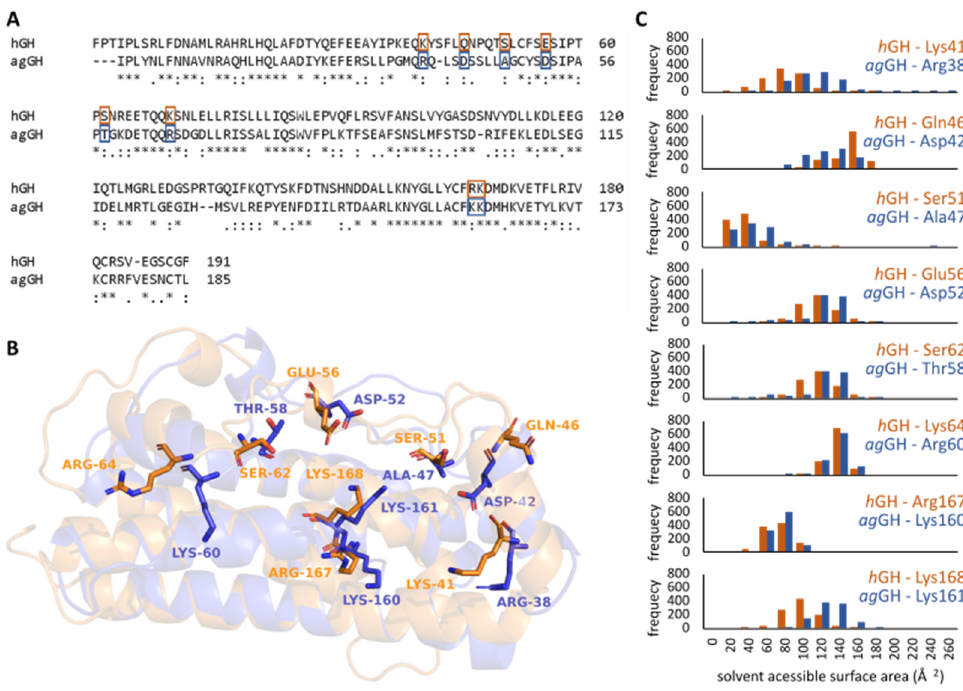
Figure 5. Alignment of hGH and agGH sequences using Clustal Omega [36], an * (asterisk) indicates positions which have a single, fully conserved amino acid residue, (colon): indicates residues with strongly similar porperties, and (period) indicates residues with weakly similar properties ( A ). Alignment of three-dimensional structures highlighting the residues reported to be involved in binding at the receptor’s binding site ( B ). Histograms of calculated solvent-accessible surface area distribution of each amino acid residue from both models during MD simulations ( C ).